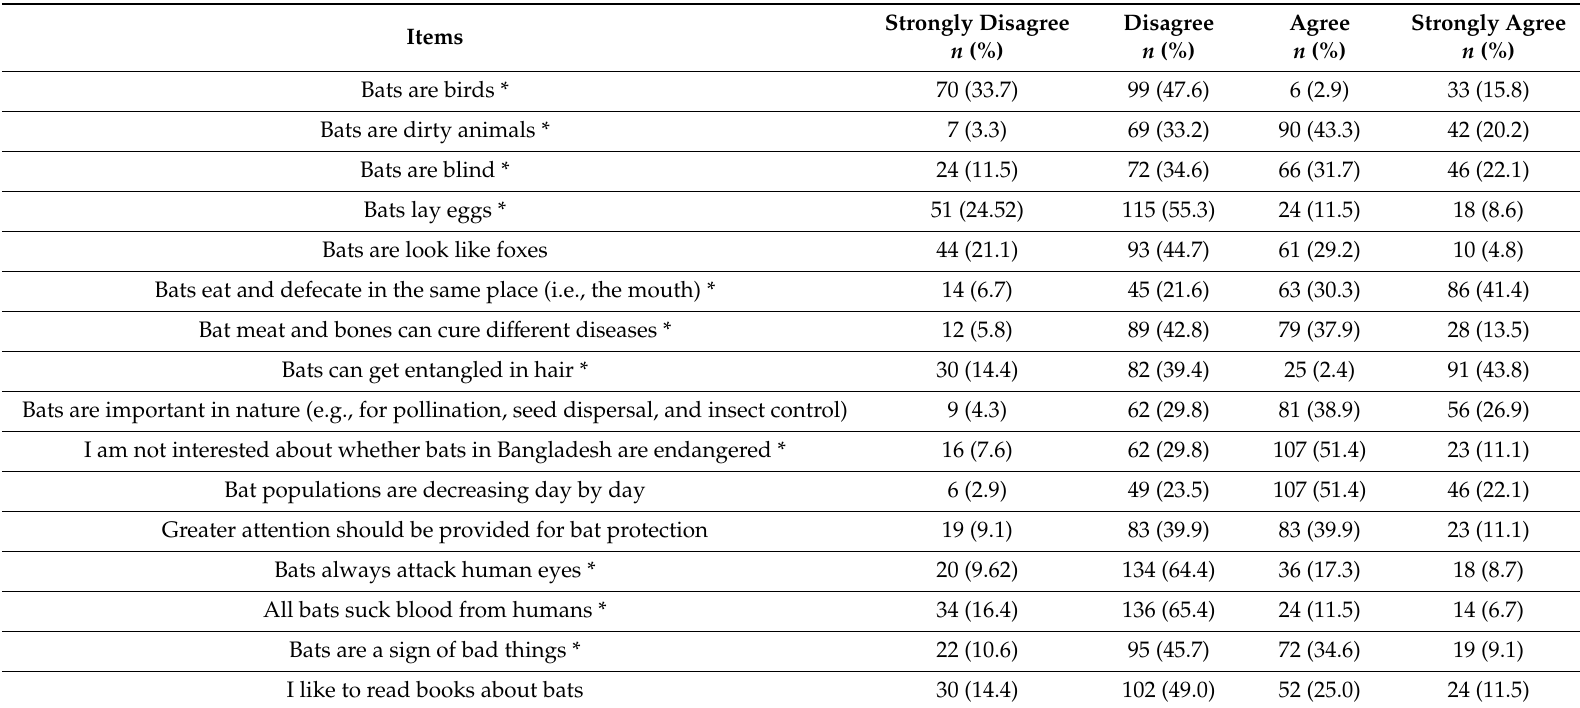
Table 2. Knowledge, attitudes, and perceptions of the ecology and myths of